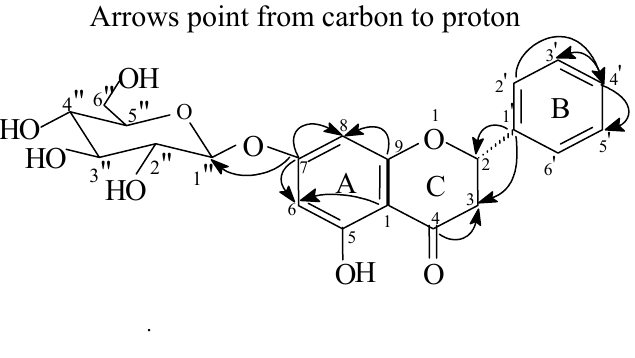
Figure 2. Heteronuclear multiple-bond correlations for 2 . Arrows point from carbon to